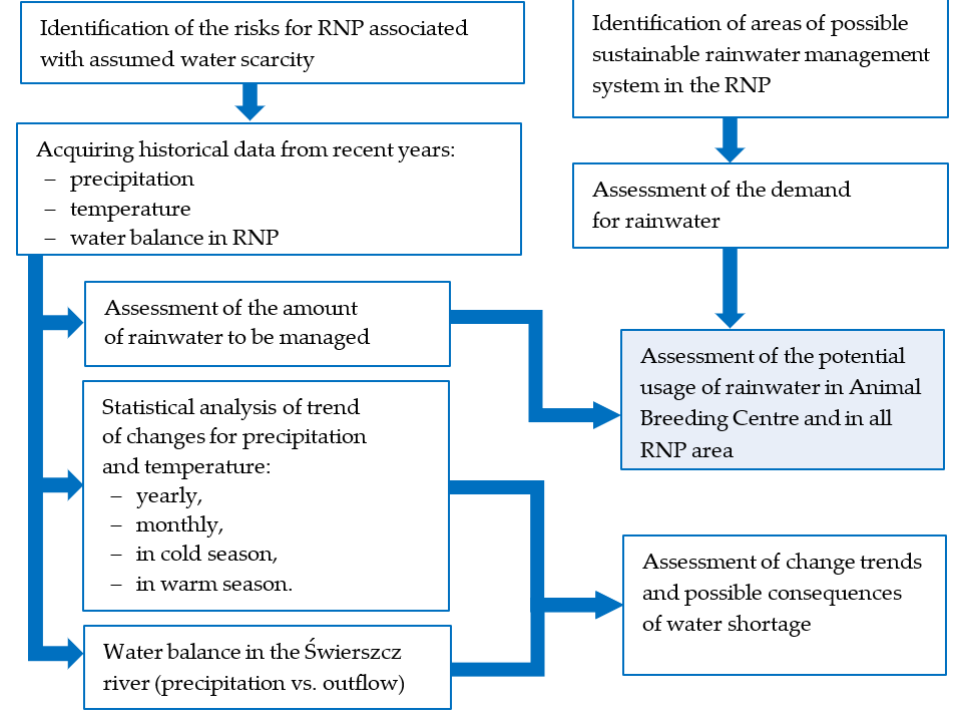
Figure 3. The aspects and order of procedures in the research methodology.